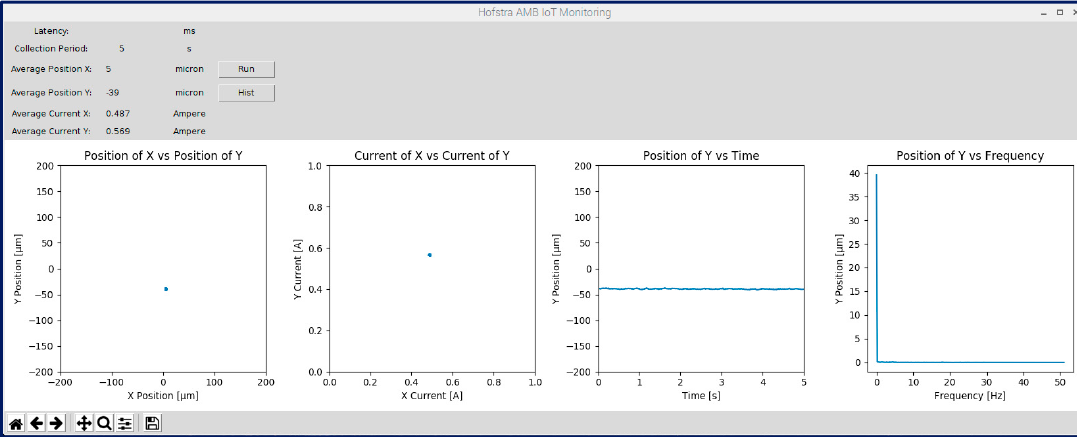
Figure 7. AMB IoT condition monitoring GUI display for non-rotating shaft with two collars.